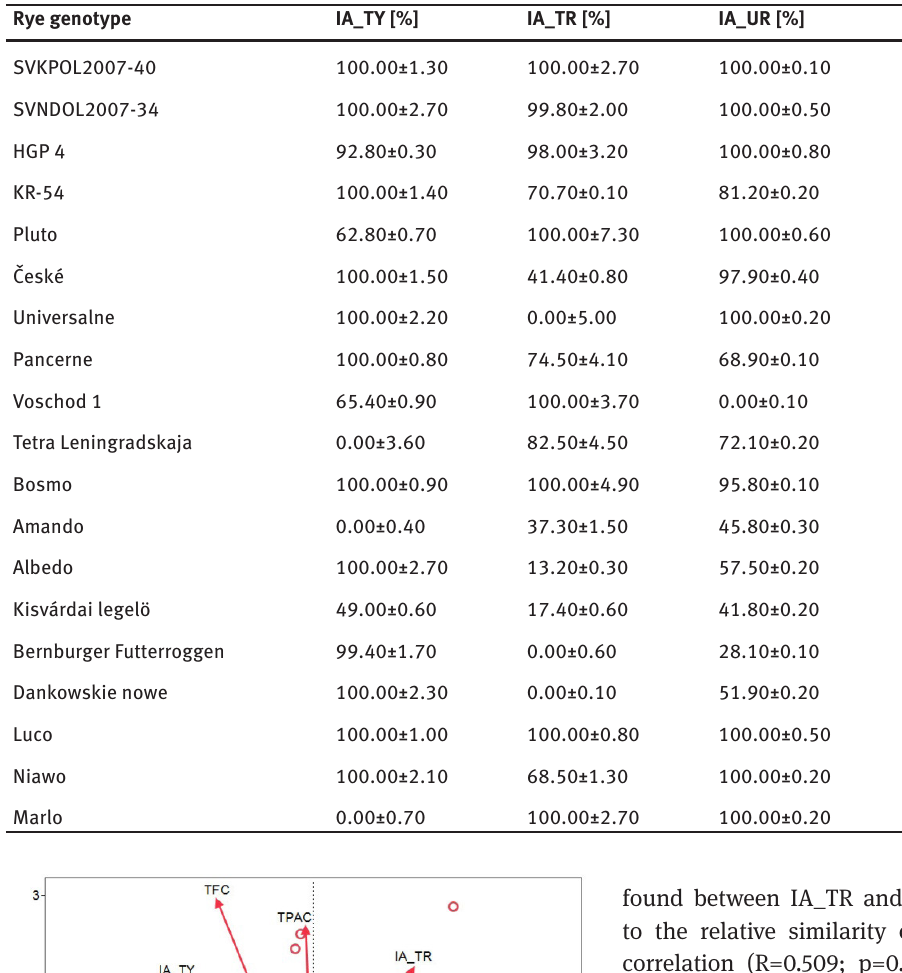
Table 4: Proteinase inhibitory activities of extracts from rye grains. Rye genotype